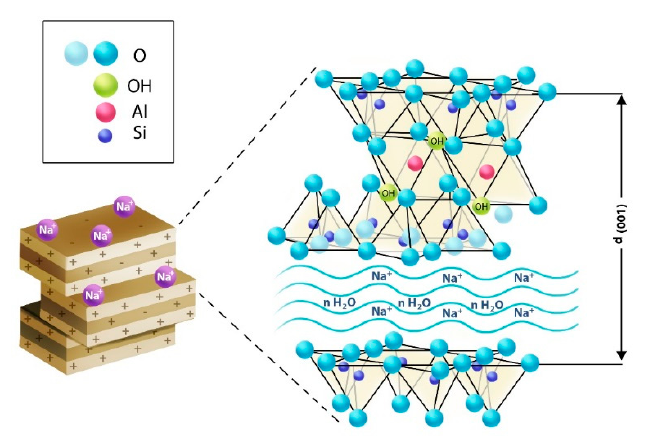
Figure 10. Schematic representing the structure of MMT, including functional groups and possible intercalation between the plates.